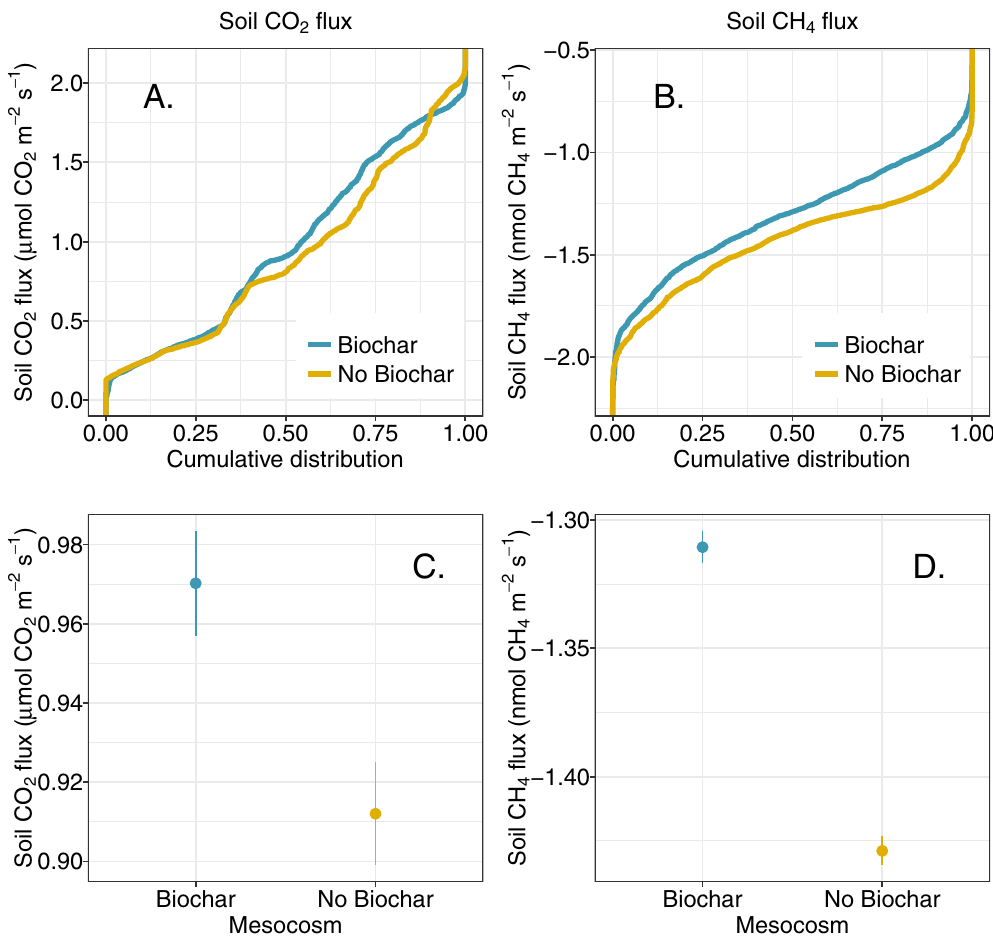
Figure 3. Cumulative distribution of soil CO 2 effluxes ( A ) and soil CH 4 fluxes ( B ) for Biochar and No Biochar conditions over the wetting and drying cycles. Mean soil gas fluxes ( ± 1 standard error) are presented for CO 2 ( C ) and CH 4 ( D